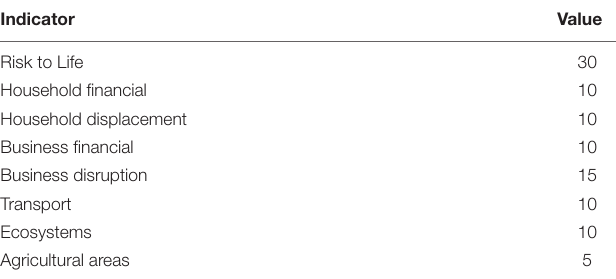
TABLE 8 | List of indicators and associated